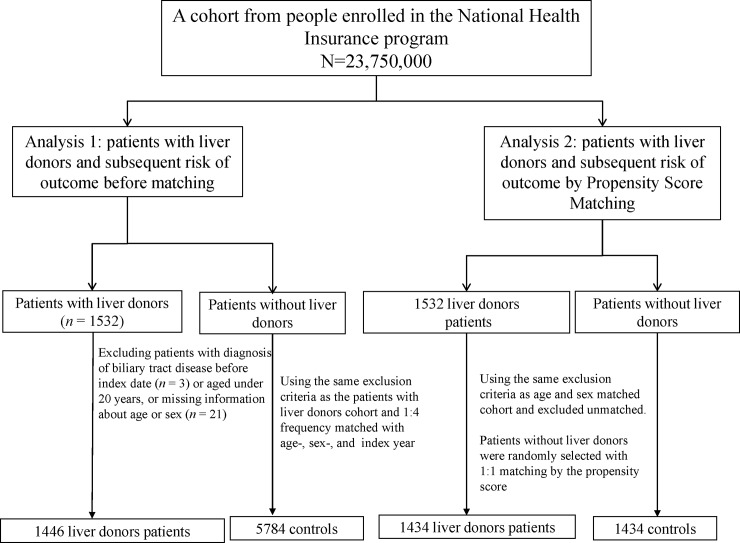
Flowchart of this propensity-matching study.